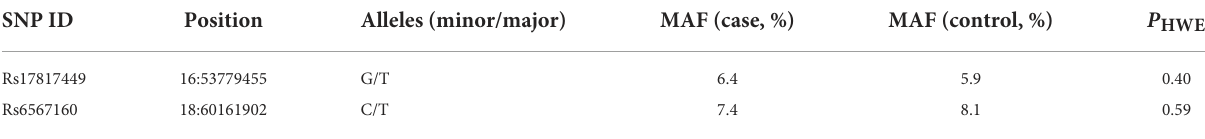
TABLE 2 Allele distributions of rs17817449 and rs6567160 ( n = 296).